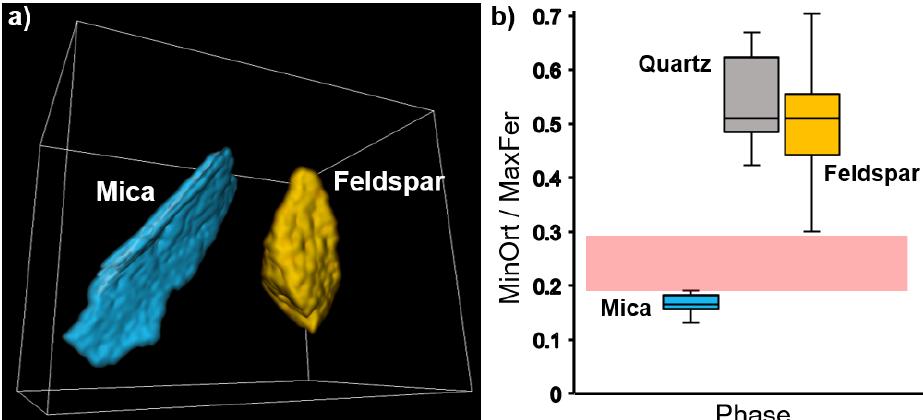
Figure 8. ( a ) 3D image of two particles, mica is blue and feldspar is yellow. ( b ) Box plot of the variability of the shape parameter—minimum orthogonal length divided by the maximum Feret diameter (O min /F max ) of 28 particles of quartz, mica and feldspar. The red band marks the range of O min /F max without an overlap between mica and feldspar.